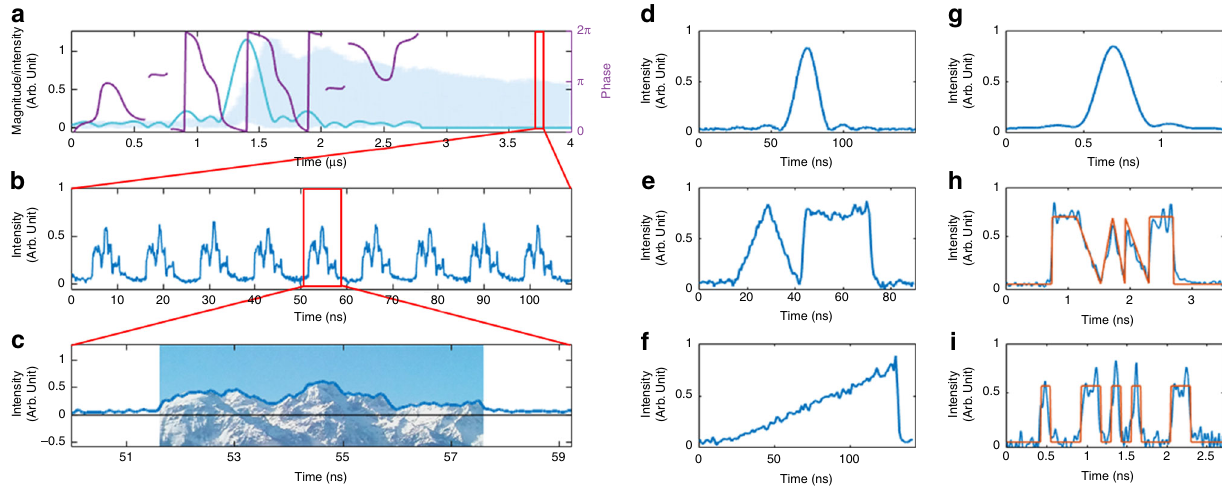
Fig. 4 Demonstration of baseband RF AWG. a – c example of generation of an arbitrary waveform mapping the pro fi le of Belledonne mountain, near Grenoble, France. a input modulation signal (light blue: amplitude, purple: phase) and output time trace (blue background). b train of nine consecutive emitted waveforms (rep. rate: 84.91 MHz). For clarity, the temporal scale has been shifted by 3.77 µ s. c comparison of a single output waveform to the desired pro fi le. d – f examples of ~100 ns long arbitrary waveforms with various shapes (sinc 2 , triangular and fl at-top, and a linear ramp). The FSL is implemented such as: f s = 9.482 MHz. The maximum signal bandwidth is limited by the 3.5 GHz detection bandwidth. g – i broadband baseband AWG (sinc 2 , broken lines pro fi le, and on-off keying modulation for digital communications at 8 Gbits/s ( “ 0100011010100011 ” in Binary, corresponding to “ 46A3 ” in Hex.). The orange plots correspond to the target waveforms. The FSL is implemented such as f s = 84.91 MHz. The maximum signal bandwidth is 25